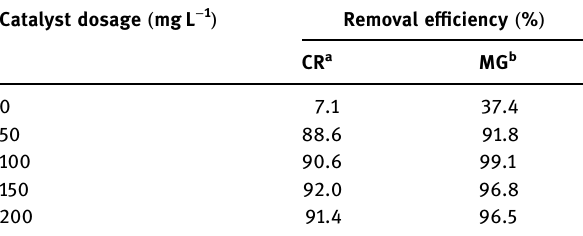
Table 1: E ff ects of catalyst dose on the removal e ffi ciency of CR and